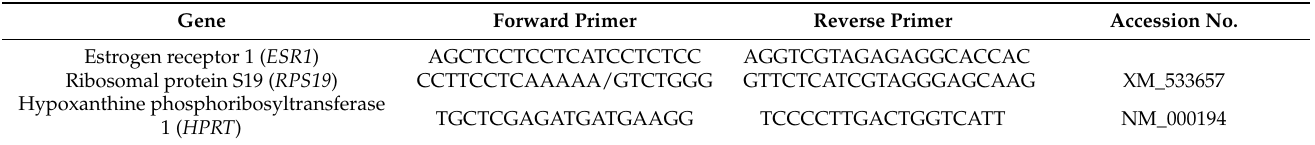
Table 2. Sequences of the primers used in this study